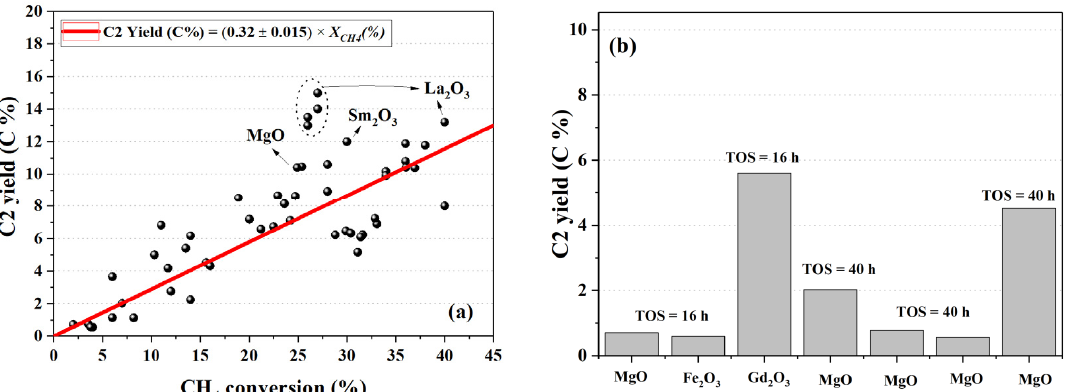
Figure 29. C2 yields as a function of CH 4 conversion over monometallic oxides ( a ) and C2 yields for different catalysts after reaction times (time on stream (TOS)) longer than 16 h ( b ). Data sourced from [110,111,158–163]. Dashed circle indicates data from La 2 O 3 nanowires [163].